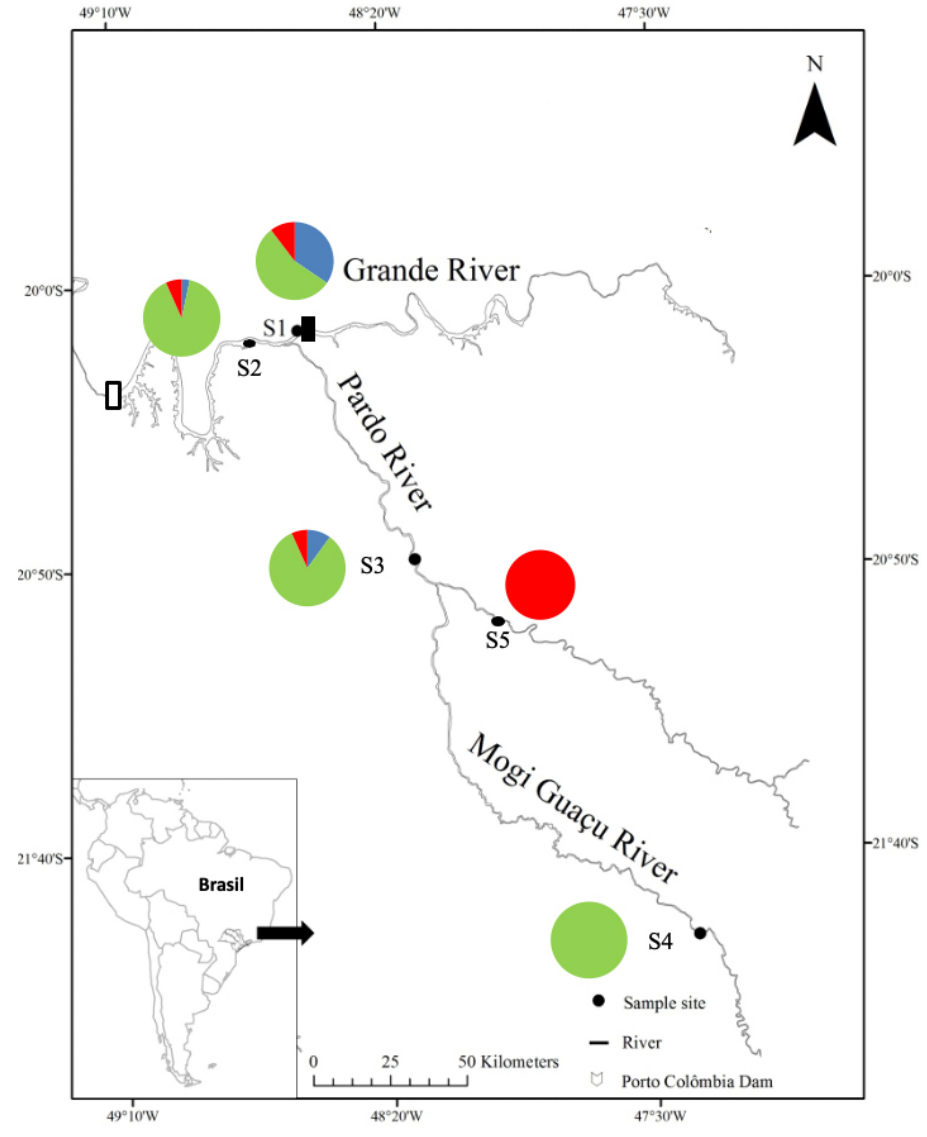
FIGURE 1 | Location of the sampling sites in the Grande River, southeastern Brazil and proposed population structuring model of Prochilodus lineatus from the Grande River basin. Pie graphs show the distribution of three genetic clusters assigned by Structure in the five geographic sampling sites: S1, Grande River immediately downstream from the Porto Colômbia dam; S2, Grande River downstream from the confluence with the Pardo River; S3, Pardo River downstream from the confluence with the Mogi Guaçu River; S4, Mogi Guaçu River, in the region of Emas’ fall; S5, Pardo River upstream from the confluence with the Mogi Guaçu River. Black rectangle = Porto Colômbia dam; White rectangle = Marimbondo dam. Genetic assigned clusters: Cluster A in blue; Cluster B in green, Cluster C in